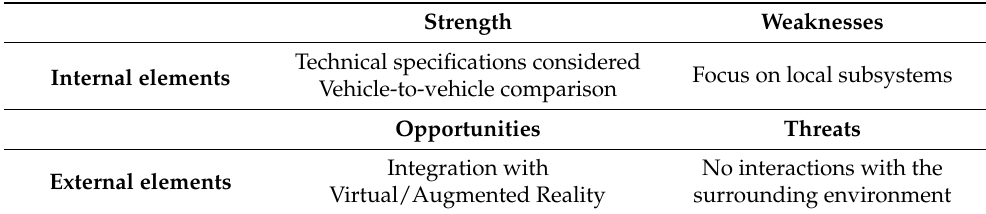
Table 3. SWOT analysis for vehicle model-driven approach. Strength